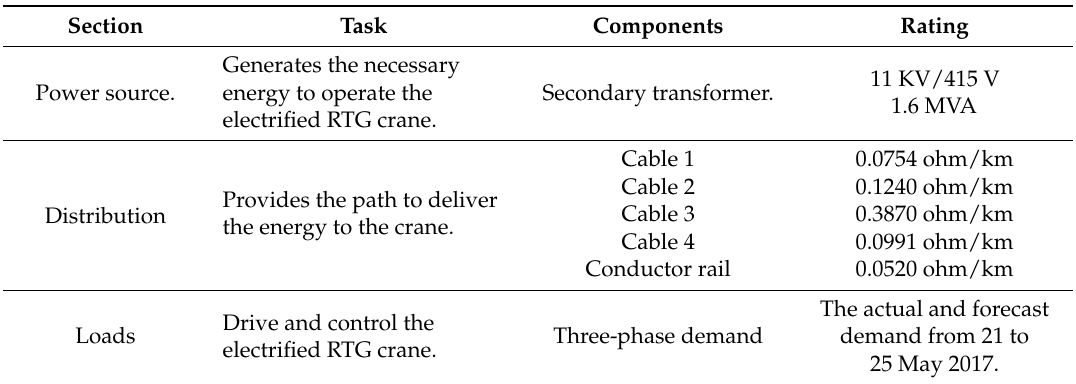
Table 2. Parameters of the electrified RTG crane